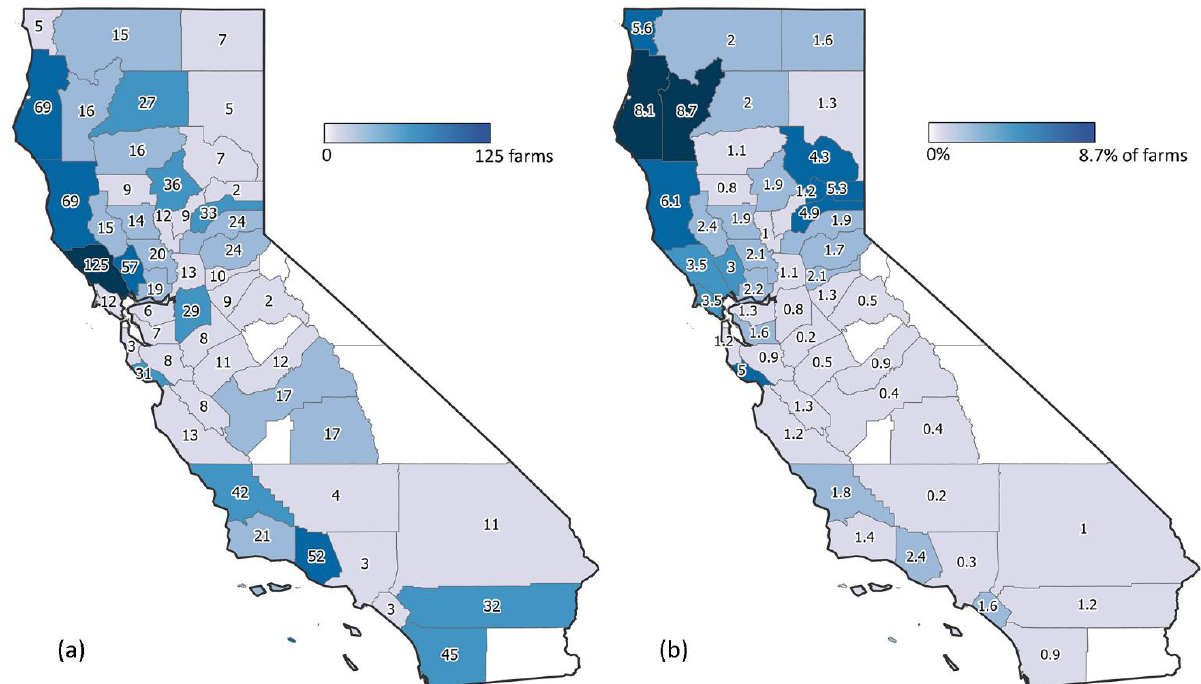
Figure 3. ( a ) Number of farms in California by county with at least one agroforestry practice based on the 2017 Census of Agriculture. ( b ) Percentage of farms in California by county with at least one agroforestry practice based on the 2017 Census of Agriculture [17] .